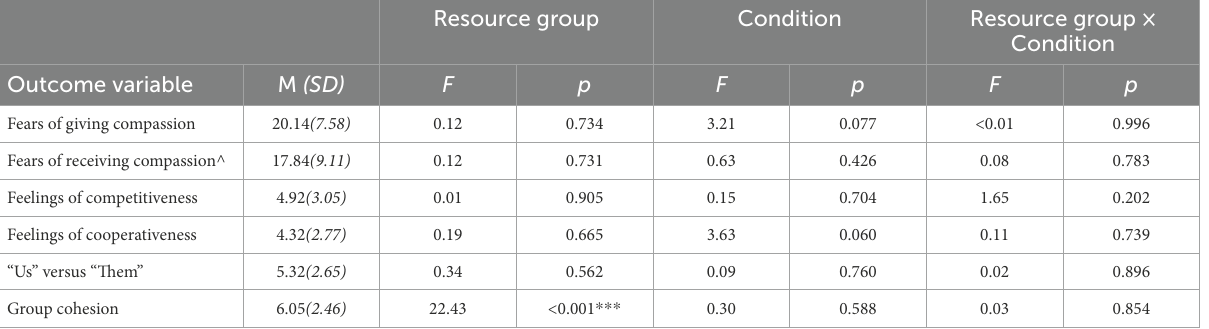
TABLE 2 Linear mixed models for Study 1 exploring the effect of condition and resource group on fears of compassion, as well as group dynamics and